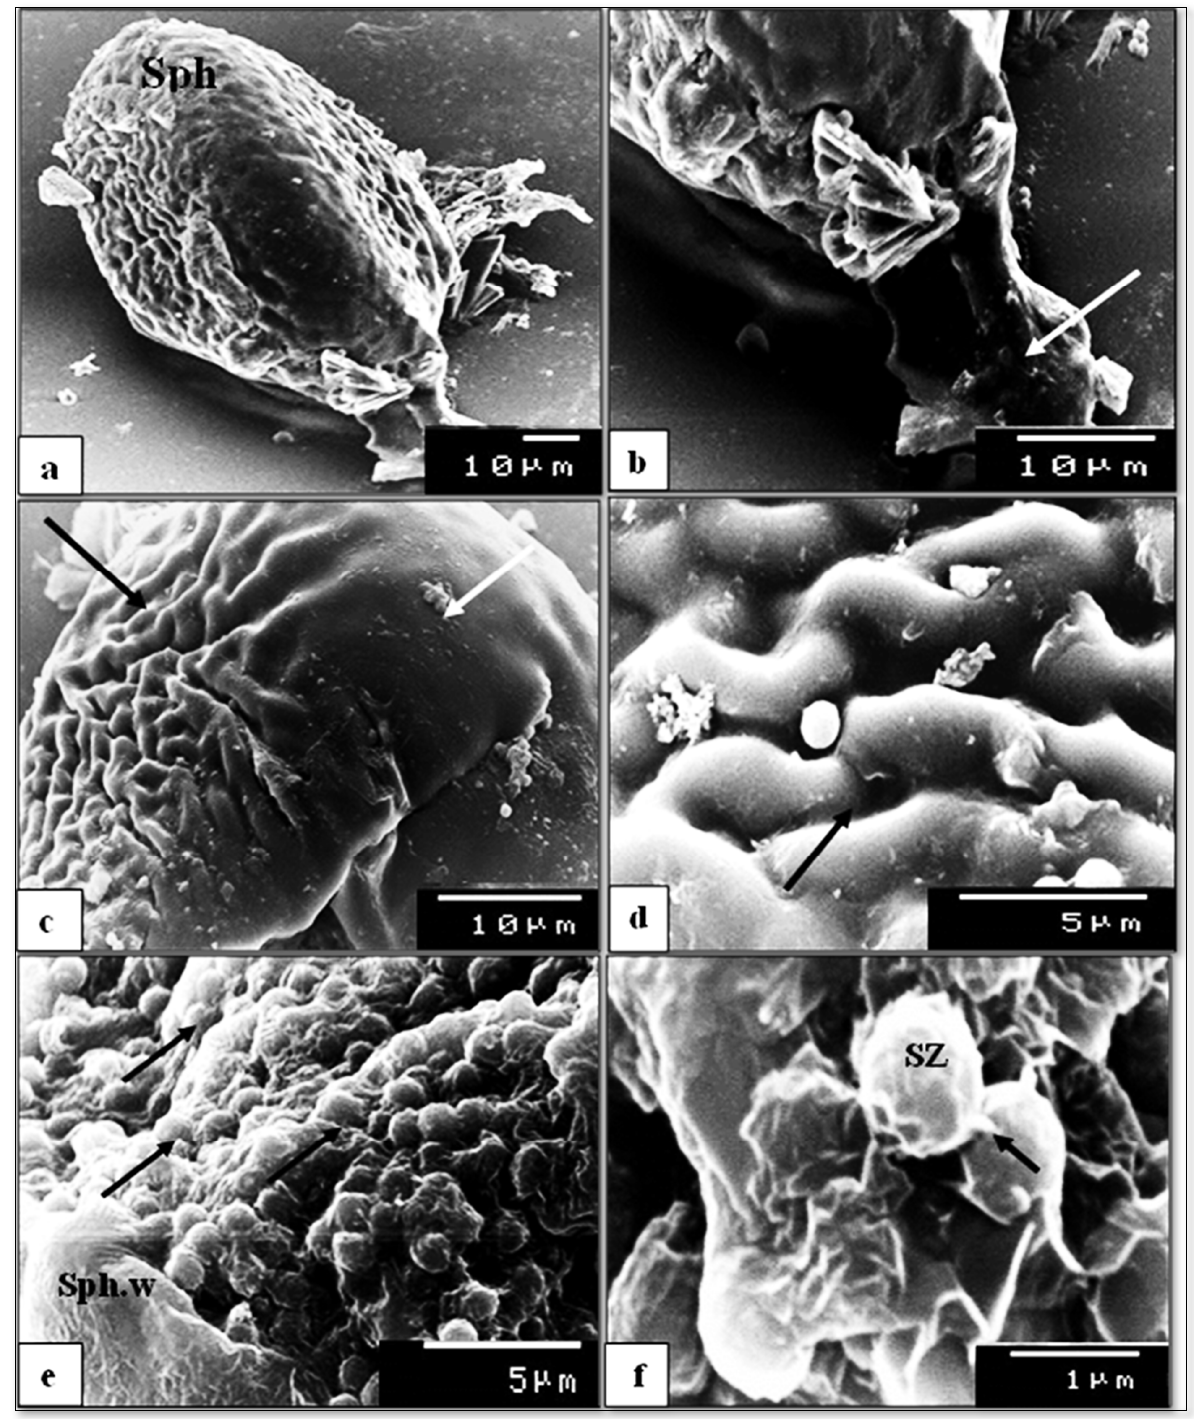
Figure 3. Electron micrograph scanning showing: fully formed spermatophore (Sph) ( a ). Electron scanning micrograph showing: the terminal stalk of the spermatophore (arrow) ( b ). Electron scanning micrograph showing: spermatophore with the smooth outer surface (white arrow) and wrinkled surface (black arrow) on both sides ( c ). An enlarged part from the previous figure showing: the wrinkled outer surface of the spermatophore with deep grooves (black arrow) ( d ). Electron scanning micrograph showing the spermatophore with its internal spermatozoa (black arrows) ( e ). An enlarged part from the previous figure showing spermatozoa (SZ) with radial arms (black arrow) ( f ).